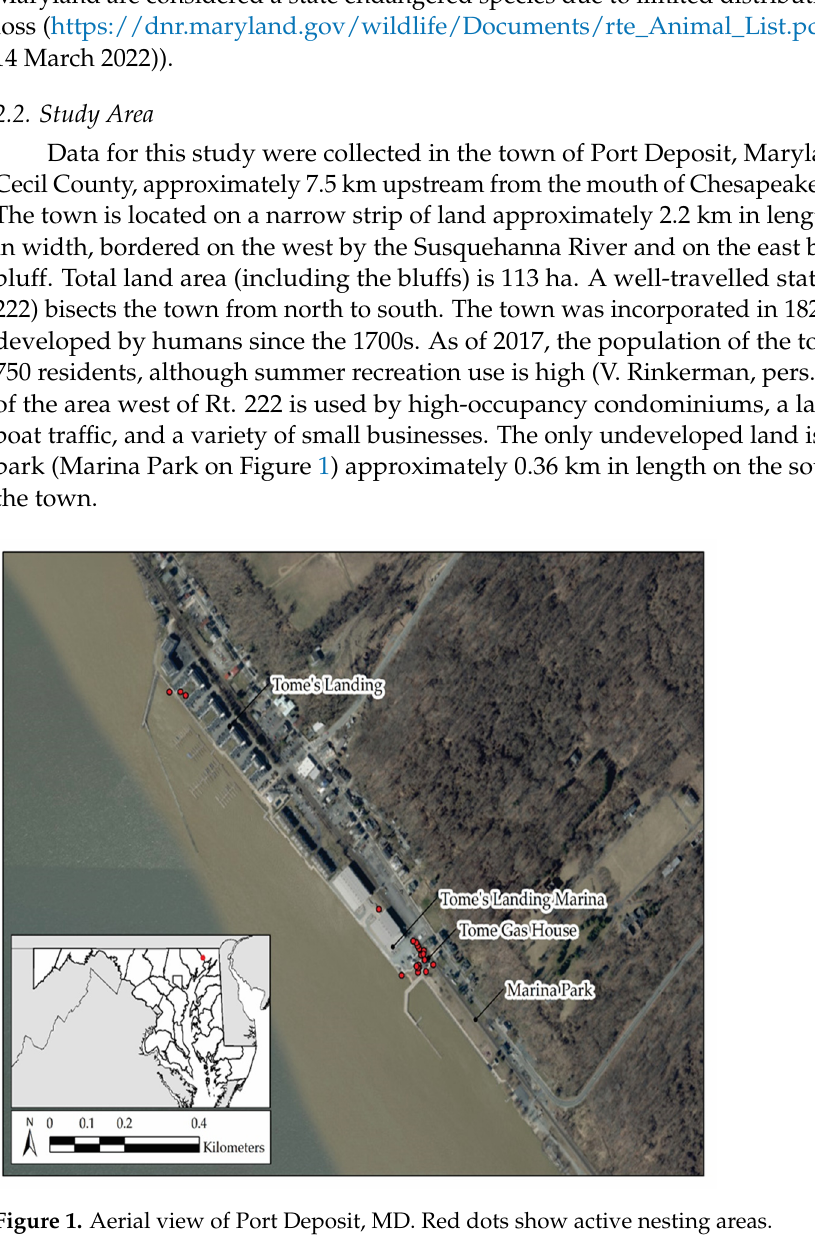
Figure 1. Aerial view of Port Deposit, MD. Red dots show active nesting areas.